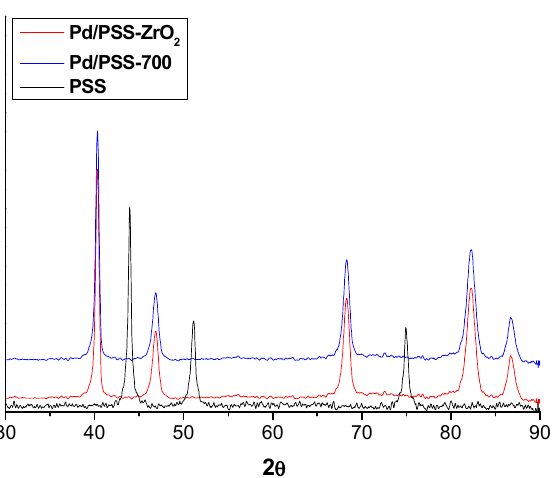
Figure 5. XRD patterns of bare PSS, Pd/PSS-700, and Pd/PSS-ZrO 2 membranes.